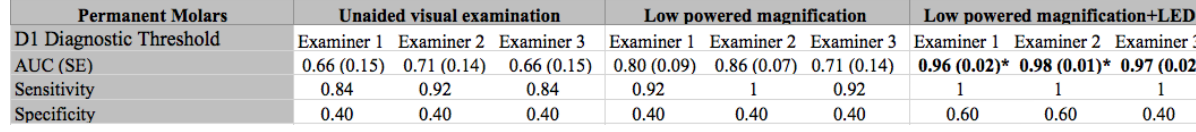
Table 8. Area under the ROC curve (Standard Error), sensitivity and specificity at D1 diagnostic threshold in permanent teeth. AUC+Area under the curve; SE=standard error * Statistically significant difference (p<0.05)